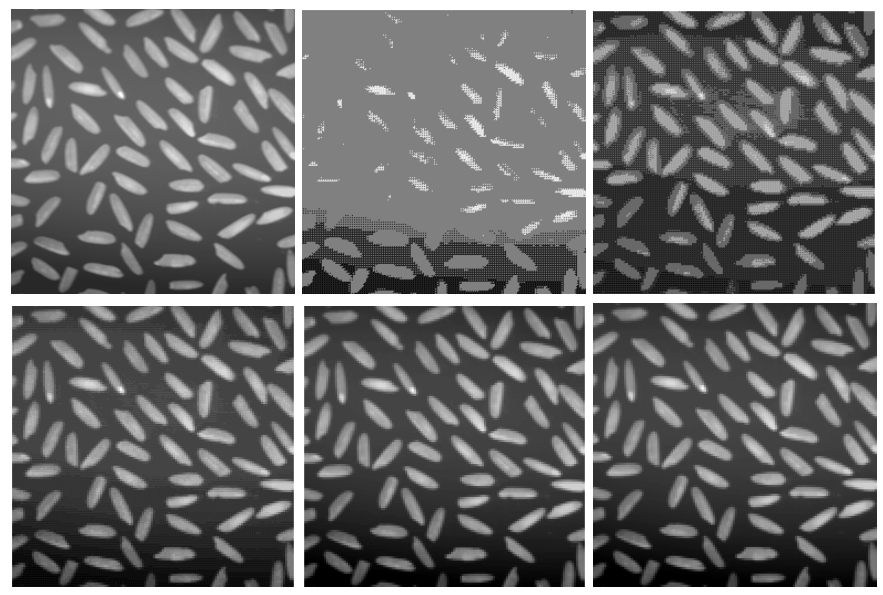
Figure 4: Top left corner: orinal image; left to right: reconstructed Rice image using 2 × 2 blocks at quality indices 5 , 10 , 50 , 90 , 95 .